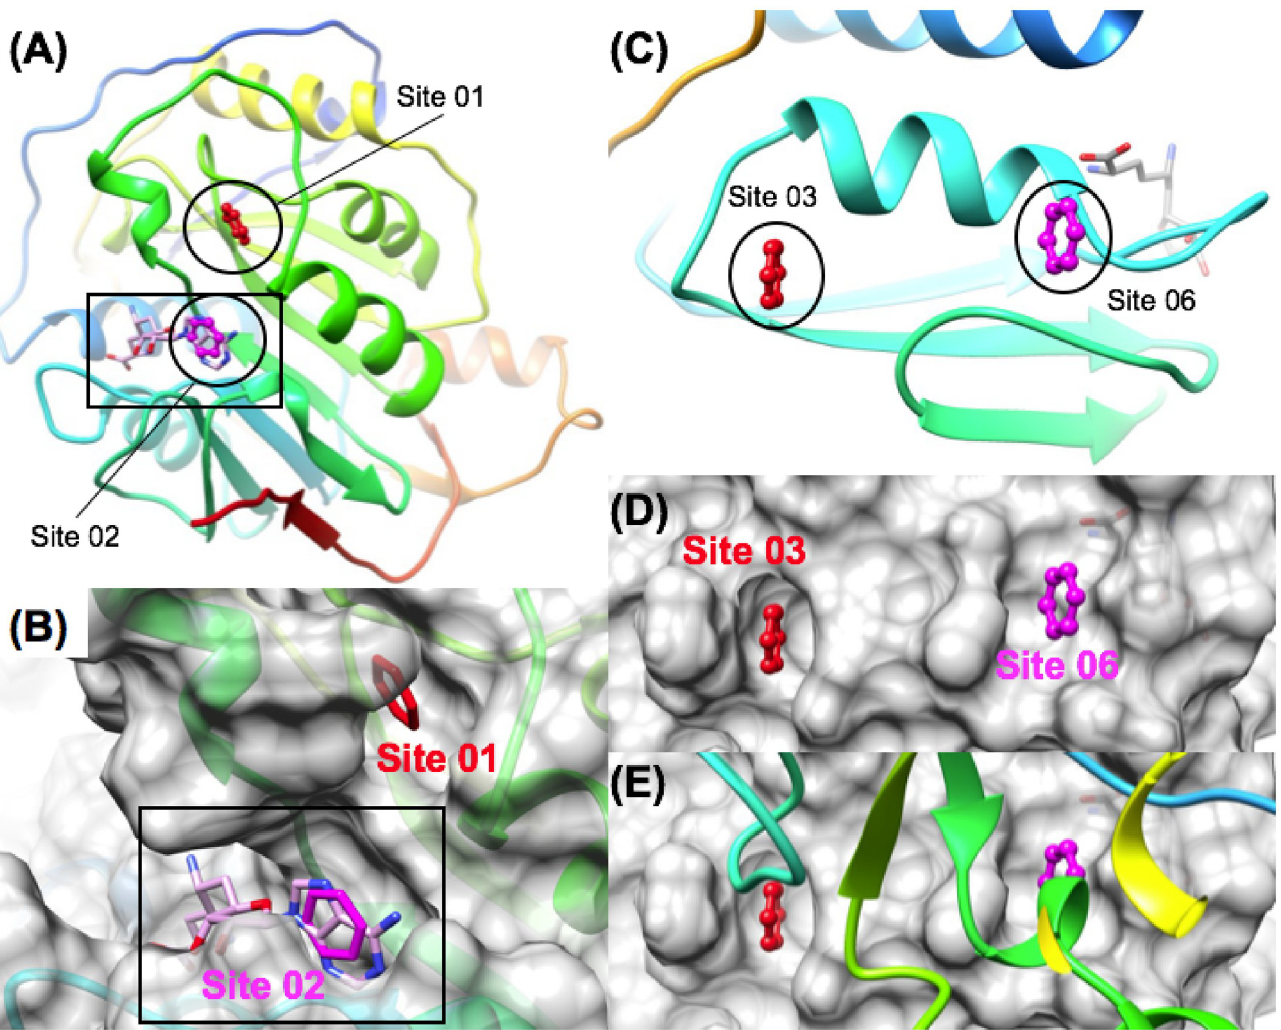
Fig 8. Pharmacophore mapping successfully identifies the Nsp16 sinefungin binding site and other PPI sites. The most favorable two sites identified are shown on a ribbon diagram in (A) and on a surface representation in (B) where Site 01 (red) was the most favorable site identified that was proximal to Site 02 (magenta), which superimposes with the most favorable pharmacophore site in the bound sinefungin structure. Two protein-protein interaction (PPI) sites on the Nsp16 binding surface were identified as favorable aromatic pharmacophore binding sites shown in (C) and (D). Site 03 (red) and Site 06 (magenta) represent Nsp16 / Nsp10 heterodimer interaction sites where the Nsp10 ribbon is shown (E) in rainbow binding to the complementary Nsp16 surface shown in gray.